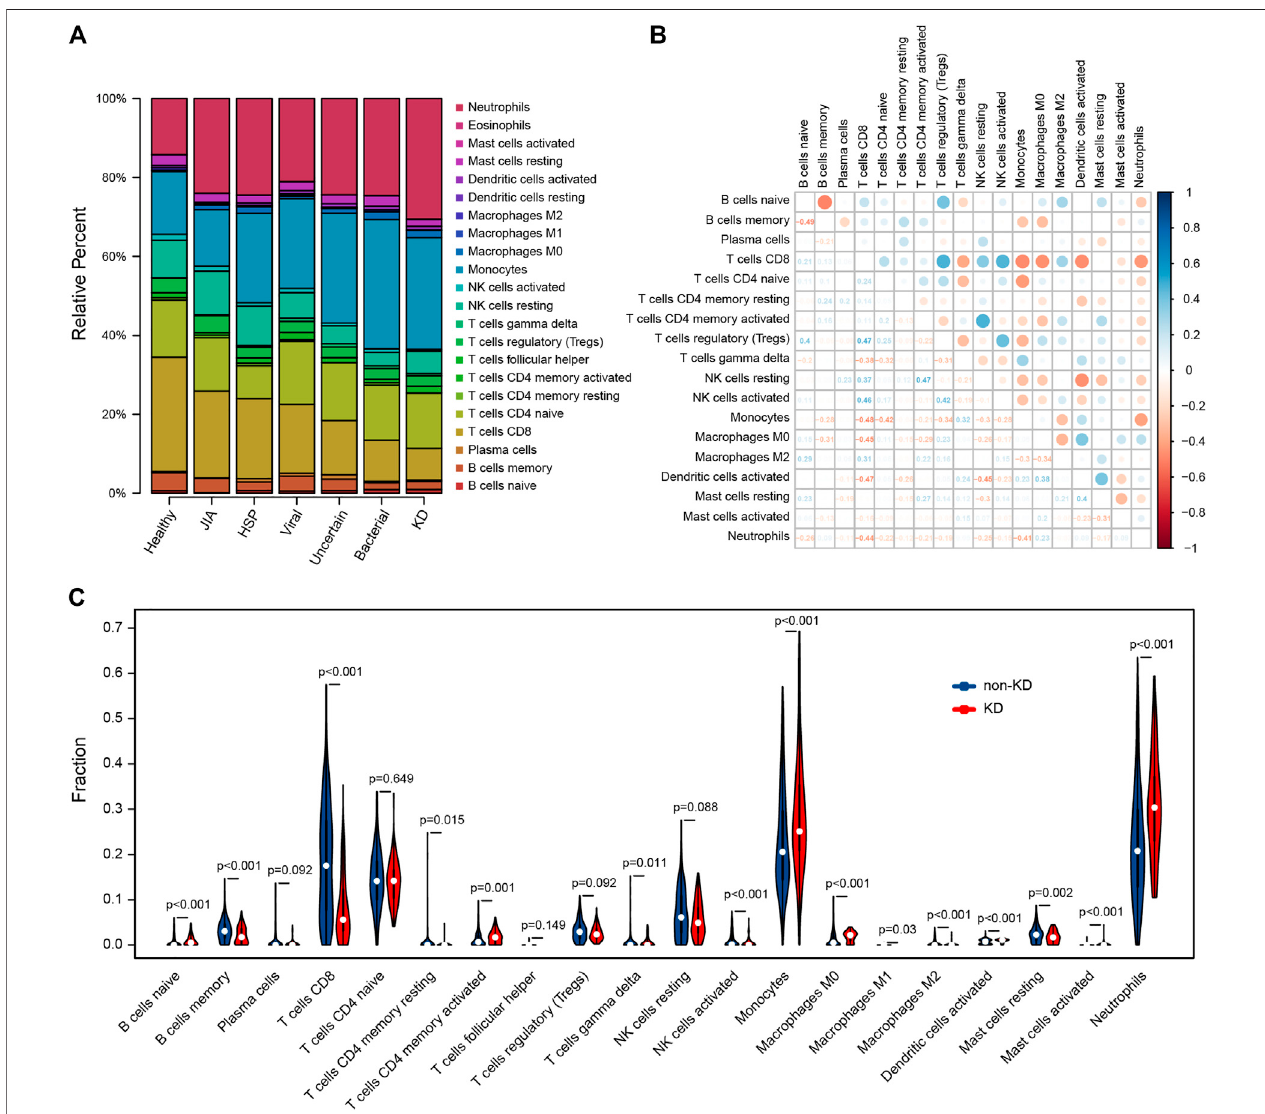
FIGURE 6 | Evaluation and visualization of immune cell analyses. (A) Relative percentage of 22 immune cell subpopulations in 459 samples from GSE73461 dataset,resultsfromdifferentdiagnosticclassi fi cationswereaveraged. (B) Correlationplotof18immunecells(4typesofimmunecellshadanestimatedabundanceof0) in 78 KD samples from GSE73461. The size of the colored dots represents the strength of the correlation; blue indicates the positive correlation, and red indicates the negative correlation; the larger the dots and the darker the color, the stronger the correlation. (C) The difference of 20 types of immune cells between KD and non- KD (2 types of immune cells had an estimated abundance of 0); blue represents non-KD, and red represents KD; p < 0.05 was considered statistically signi fi cant.